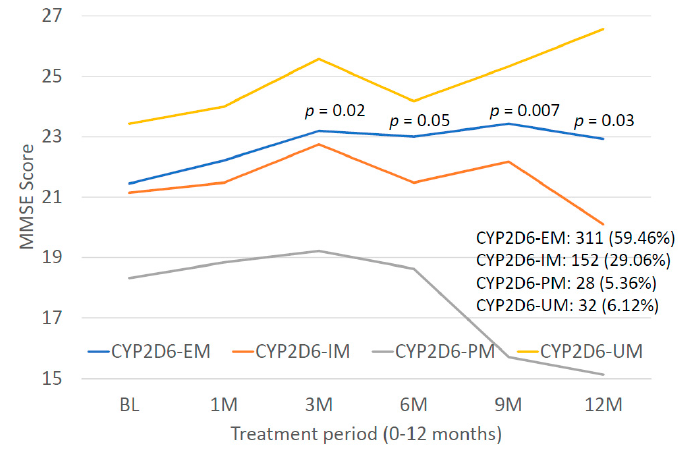
Figure 20. CYP2D6 -related therapeutic response to a multifactorial treatment in Alzheimer’s disease.